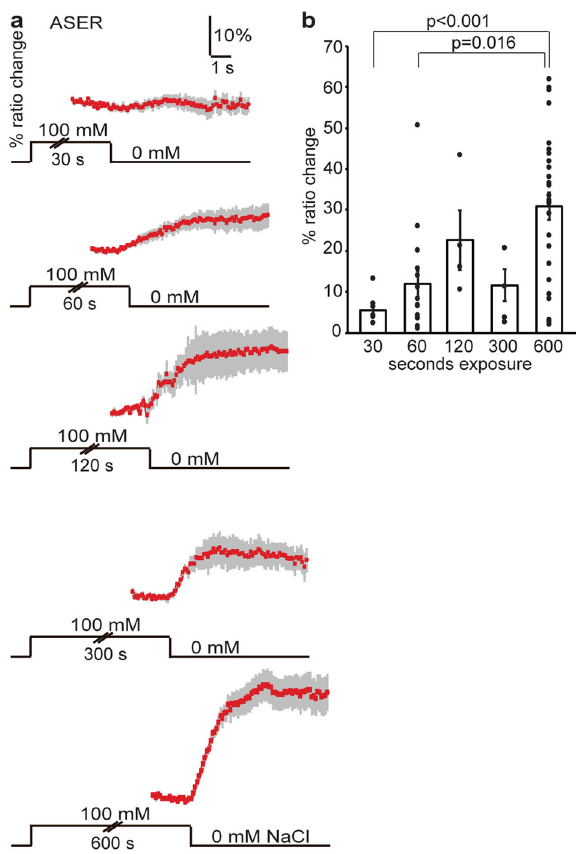
Fig. 2 Prolonged exposure to NaCl sensitizes ASER. a Average Ca 2 + transient (±SEM) in ASER in response to a decrease in NaCl concentration from 100 mM to 0 mM after 30 – 600 s exposure. Thirty seconds of exposure to 100 mM NaCl did not result in a response in ASER, but longer exposures did. b Average maximum ratio changes (±SEM) in ASER after 30 – 600 s exposure. Thirty seconds: n = 8, 1 min: n = 15, 2 min: n = 4, 5 min: n = 5, 10 min: n = 29 animals. Individual data points have been indicated as dots. Statistically signi fi cant differences have been indicated (non- signi fi cant differences, p > 0.05, have not been indicated). Source data underlying this fi gure are available in Supplementary Data